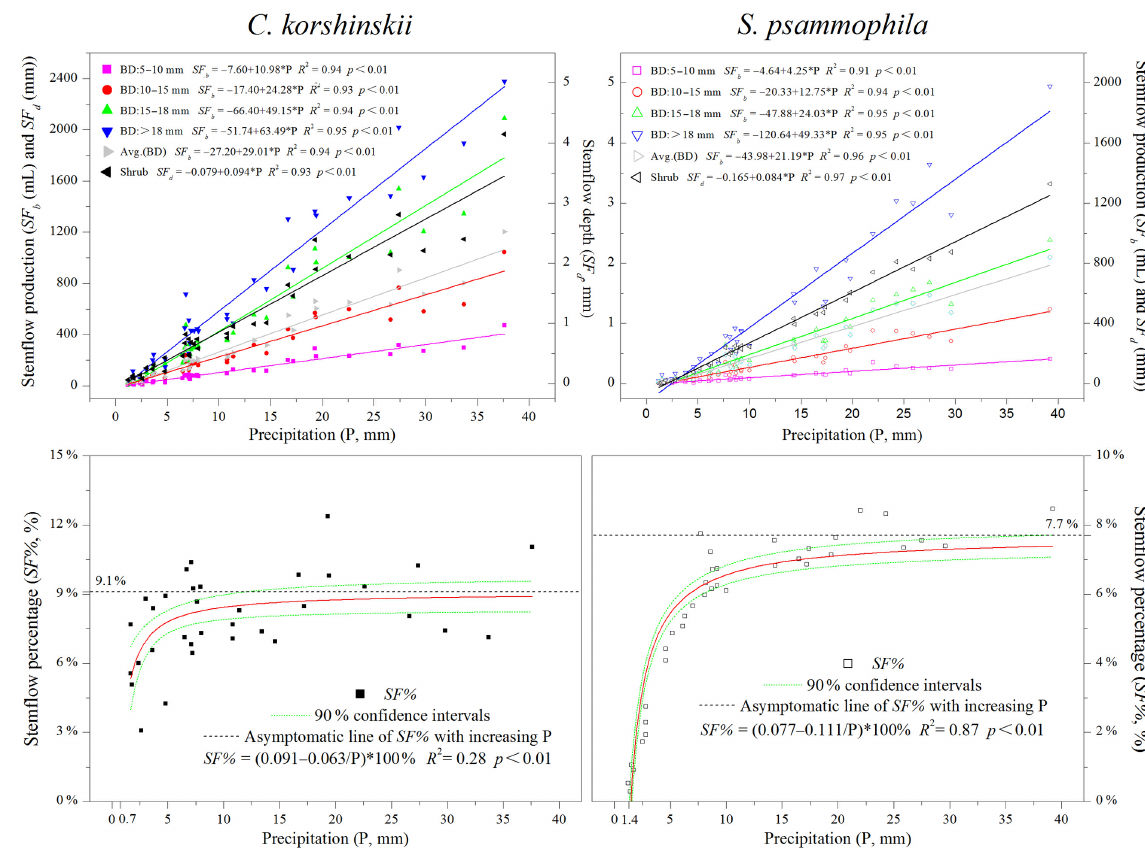
Figure 5. Relationships of branch stemflow volume (SF b ), shrub stemflow depth (SF d ) and stemflow percentage (SF%) with precipitation amount ( P ) for C. korshinskii and S. psammophila